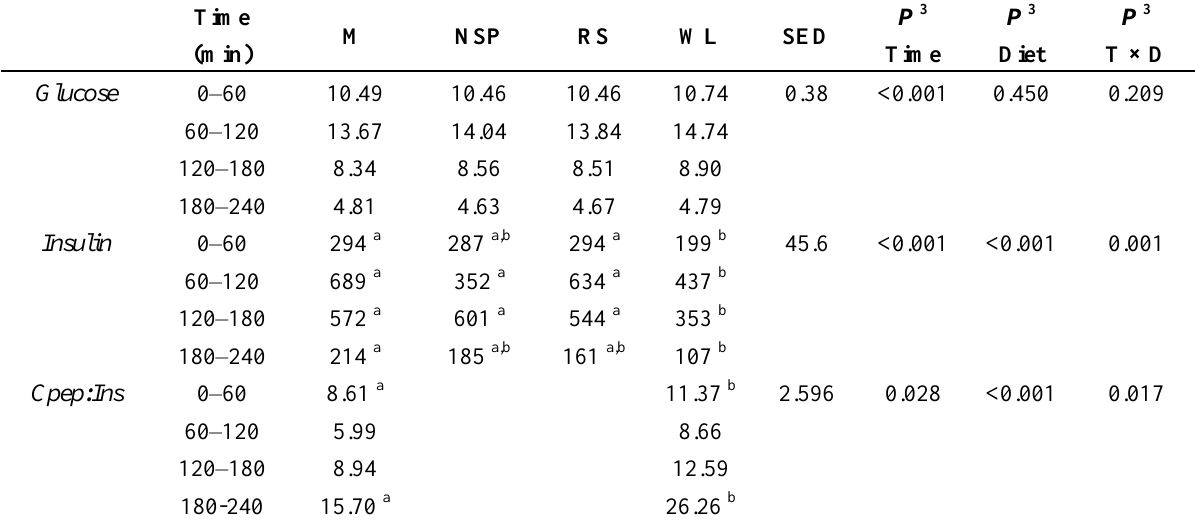
Table 3. Average 1 glucose (mM), insulin (pM) and C-peptide to insulin molar ratios for 60 min intervals for the 2 h during and 2 h after dextrose infusion in 14 volunteers after an overnight fast following the dietary interventions 2